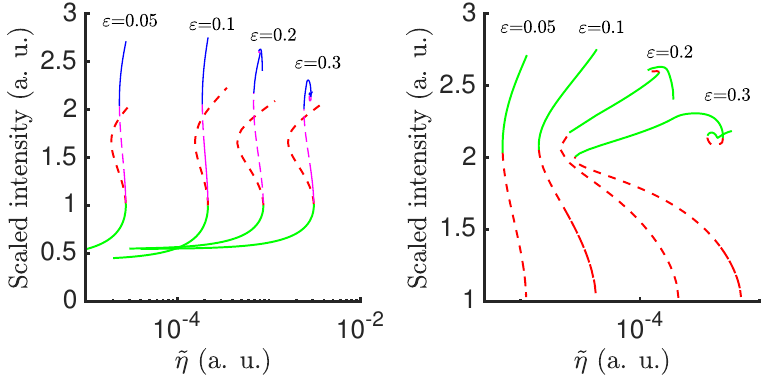
Figure 8. Bifurcation diagrams of Equation (12) obtained for different values of ε . Left panel: CW states cut around S-shaped bifurcation curve (thick lines) and periodic solutions (thin lines). Solid lines represent stable states and dashed lines represent unstable states, ˜ η = η − η ε + δη ( ε ) is a shifted value of η . Right panel: Branches of periodic solutions from the left panel, magnified. The intensity is scaled by ε 2 and other parameters are as in Figure